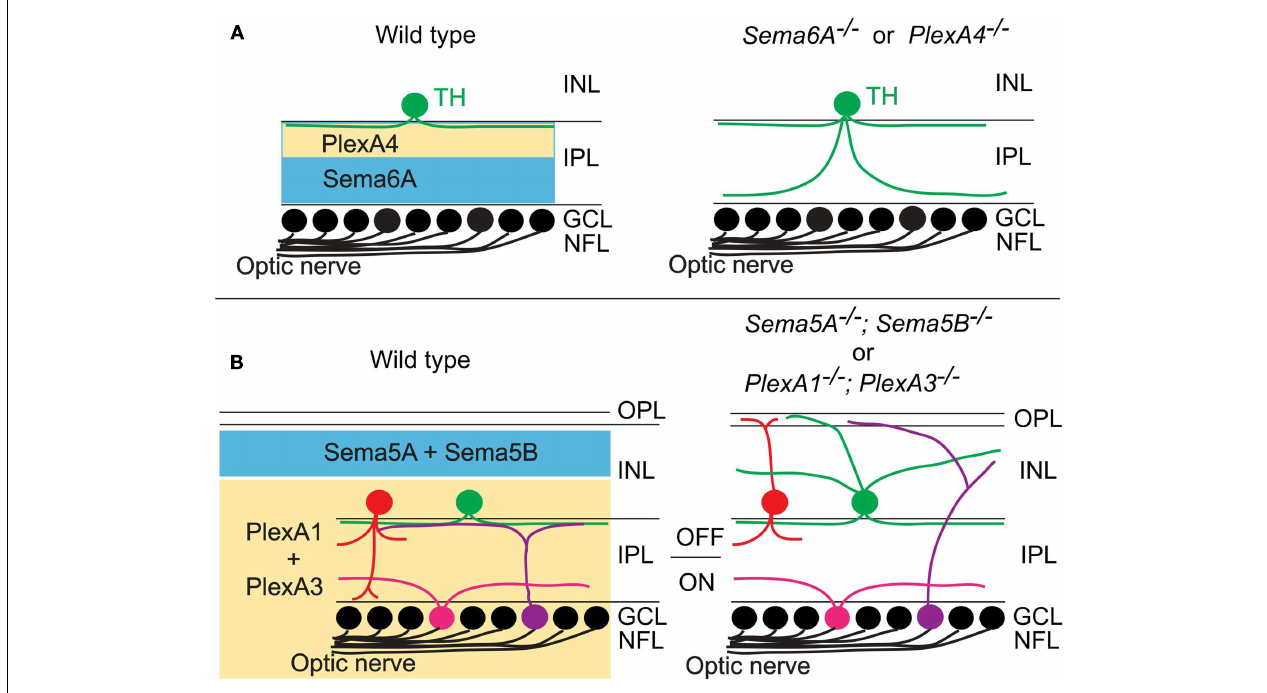
PlexA4 mutant mice, dopaminergic amacrine cells extend their aberrant processes to the S4/S5 sublaminae. (B) During early postnatal retinal development, Sema5A / 5B and PlexA1 / A3 expressions are found in a complementary pattern in the retina. Loss of Sema5A / 5B or plexA1 / A3 results in neurite mistargeting of multiple inner retinal neuron subtypes into the outer